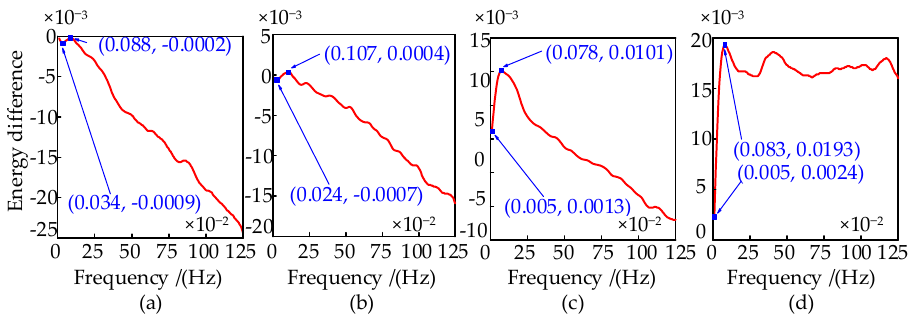
Figure 14. The energy difference curves corresponding to different percentages of thrust loss: ( a ) λ % = 10%; ( b ) λ % = 20%; ( c ) λ % = 30%; ( d ) λ % = 40%. As shown in Figure 14a, the maximum of the energy difference curve corresponding to the percentage of thrust loss of 10% is − 0.0002 at frequency 0.088. The left adjacent local minimum is − 0.0009 at frequency 0.034. Therefore, the frequency boundaries of the local region are [0.034 0.088]. Similarly, the frequency boundaries are [0.024 0.107], [0.005 0.078], and [0.005 0.083] corresponding to the percentages of thrust loss of 20%, 30%, and 40%, respectively. The frequency boundaries of the local region are set in Figure 15.